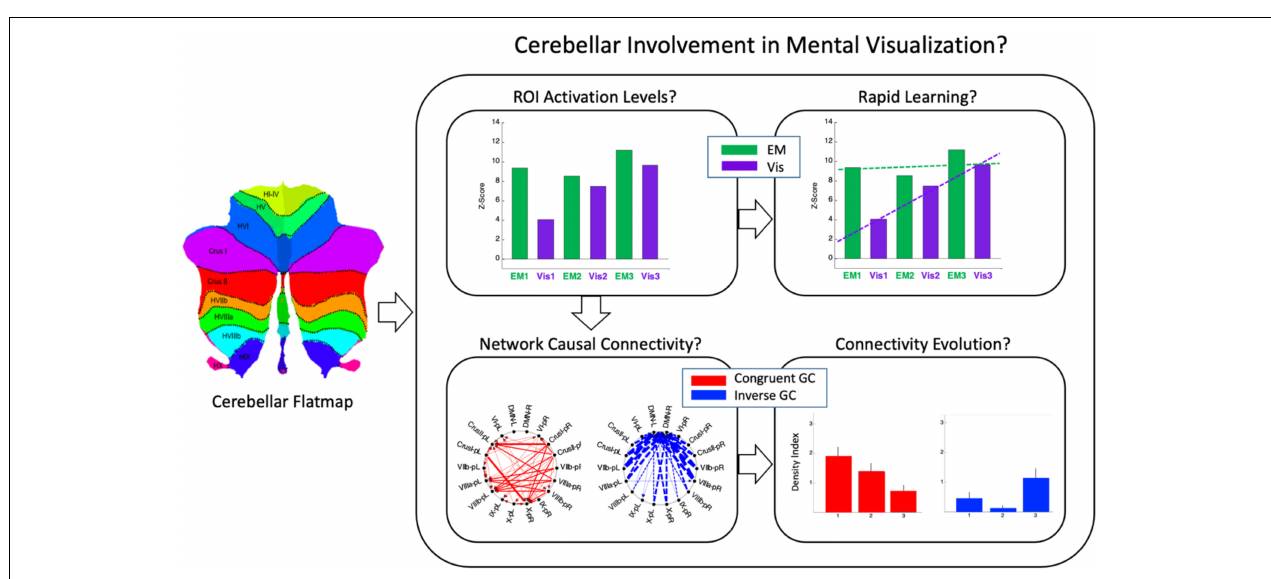
FIGURE 2 | A schematic preview that shows at glance the overall structure of the methodological design. Average cerebellar activation was mapped to an unfolded cerebellar flatmap (icon at left) where the pattern of cerebellar involvement in non-motor cognitive tasks was used to determine the activation levels in each local region of interest (ROI), and its rapid change over three repeats of each task ( top row ); Granger Causal connectivity was assessed within the respective networks of these ROIs, and the connectivity evolution over the three repeats plotted in terms of a Connectivity Density Index ( bottom row ). Two interleaved tasks: EM = Explore and Memorize ; Vis = Visualization from memory (see Figure 3 in Experimental